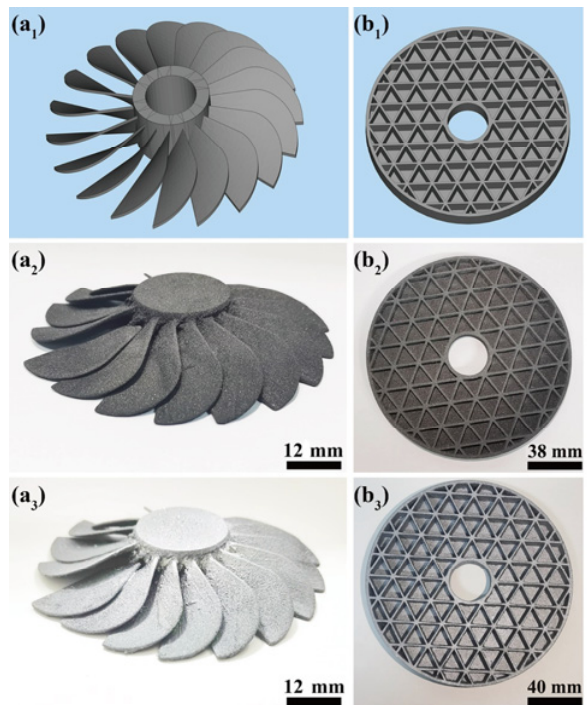
Fig. 16 C f /SiC/C green bodies and sintered SiC composites with complex structures fabricated via SLS: (a 1 –a 3 ) turbine blade; (b 1 –b 3 ) flat mirror (the subscripts 1, 2, and 3 represent the STL models, printed C f /SiC/C green bodies, and sintered SiC composites,